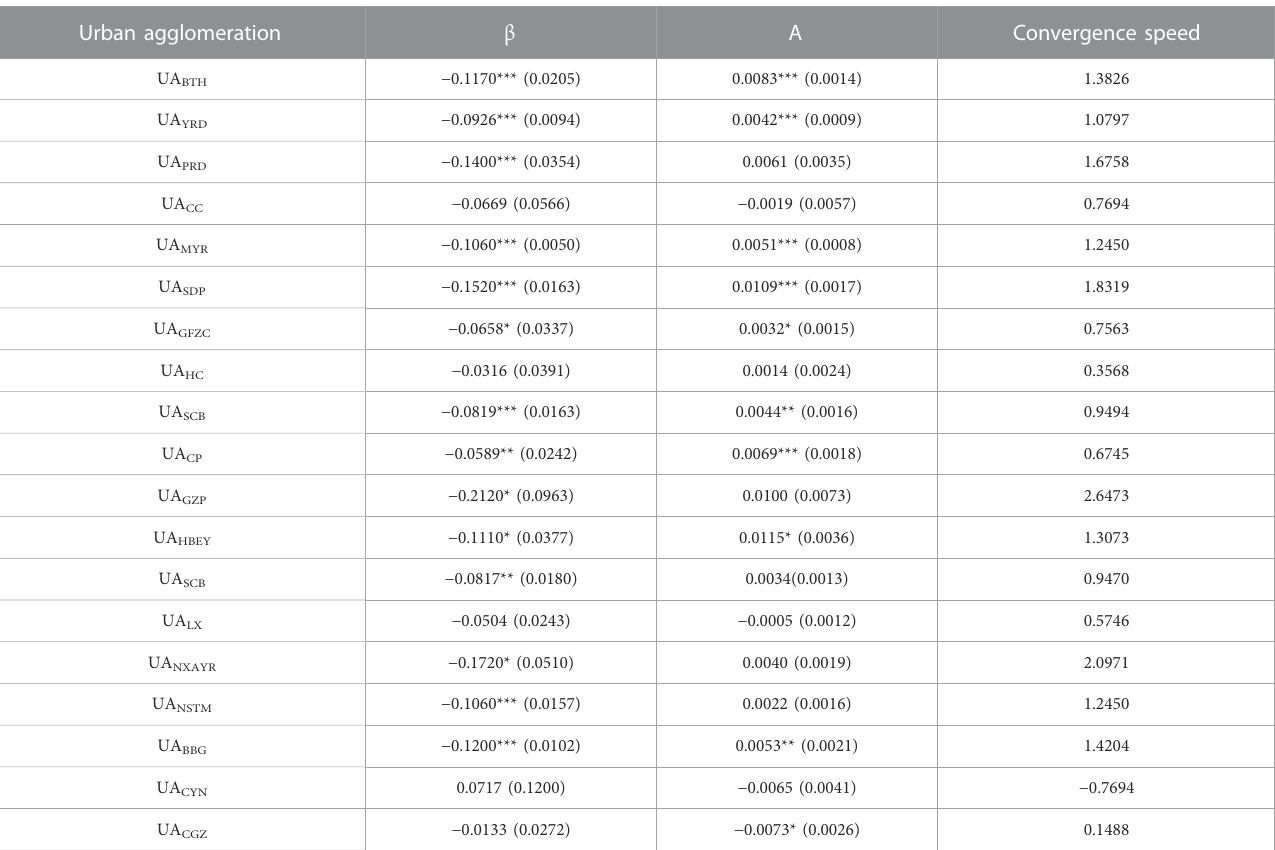
TABLE 3 Results of the absolute β test for GTFP in cities within urban agglomerations. Urban